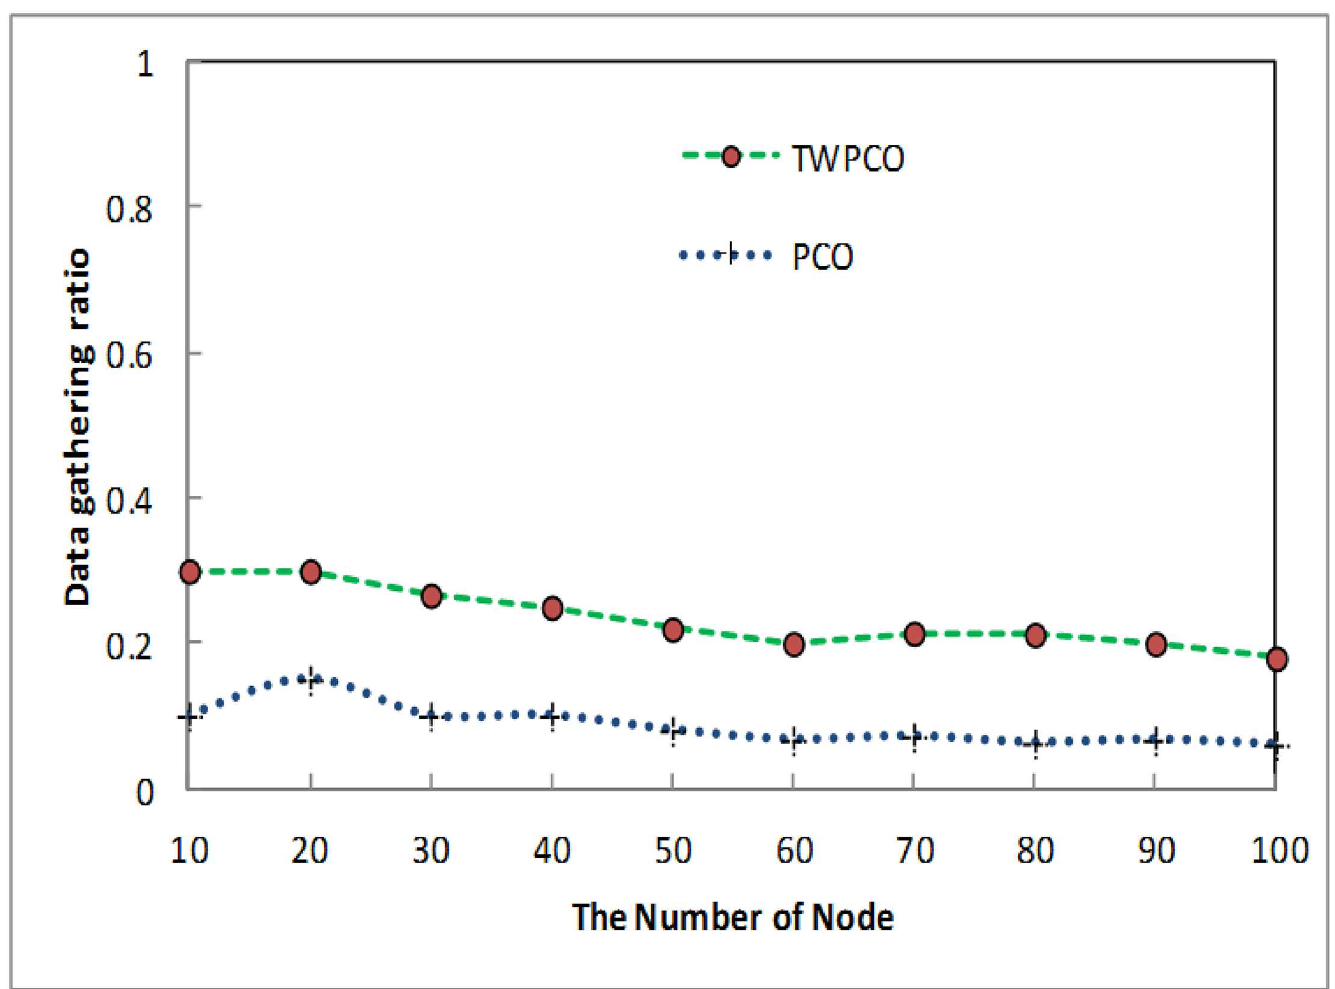
Fig 13. Data gathering ratio based on number of